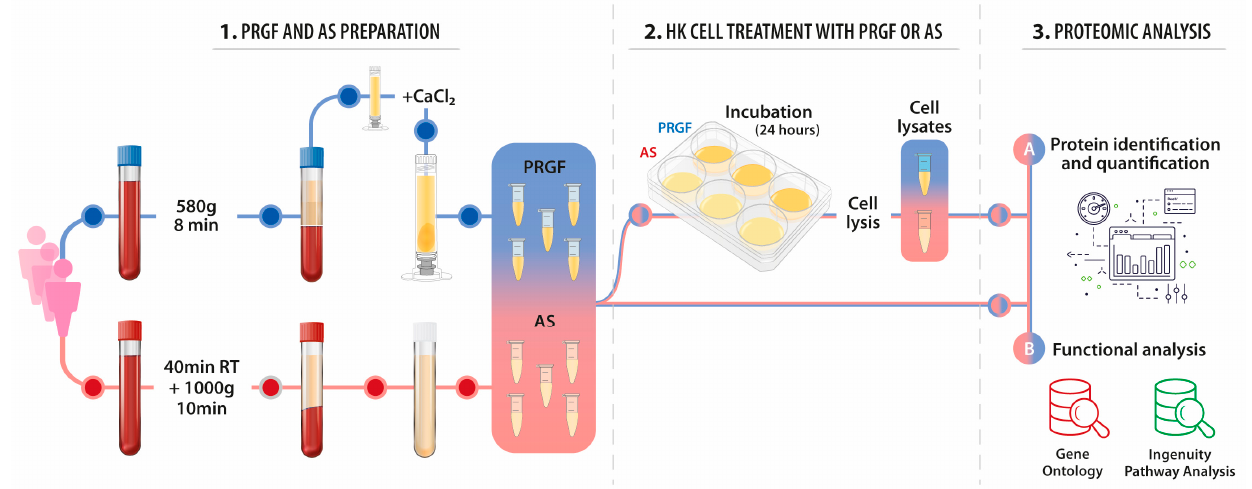
Figure 7. The study design is shown schematically. First, the two blood derivatives, PRGF and AS, were obtained. On the one hand, HK cells were incubated with these formulations to assess their response to each blood derived product by proteomic techniques. On the other hand, both PRGF and AS preparations were characterized by the same proteomic techniques.